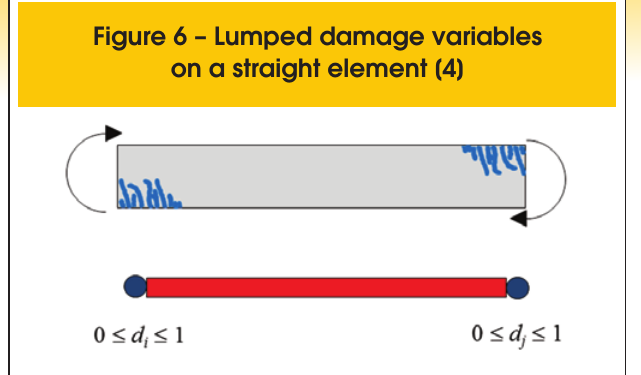
Figure 7 – Damage vs. bending moment on an inelastic